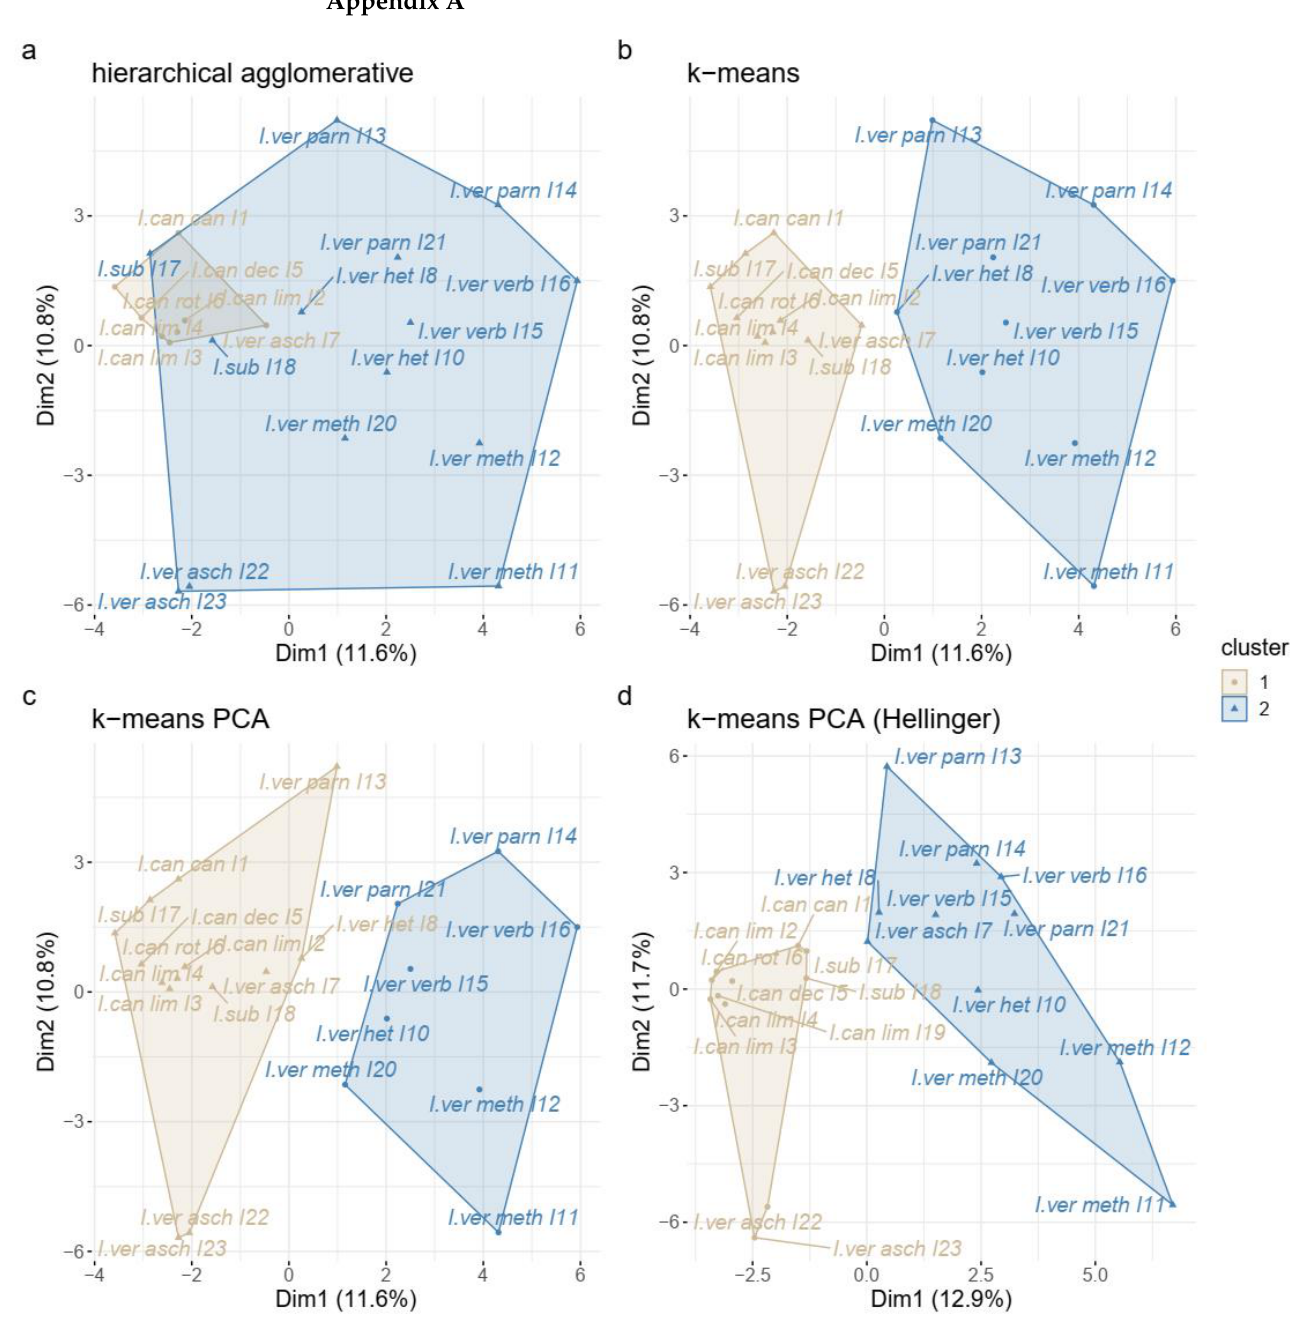
Figure A1. Classification of the Inula populations based on ( a ) the hierarchical agglomerative algorithm, ( b ) the k-means algorithm, ( c ) the k-means algorithm on the coordinates of the first eight PCA axes (accounting for 69.8% of the volatile compounds variance) and ( d ) the k-means algorithm on the coordinates of the first eight PCA (72.7%) of the Hellinger pre-transformed volatile compounds matrix.